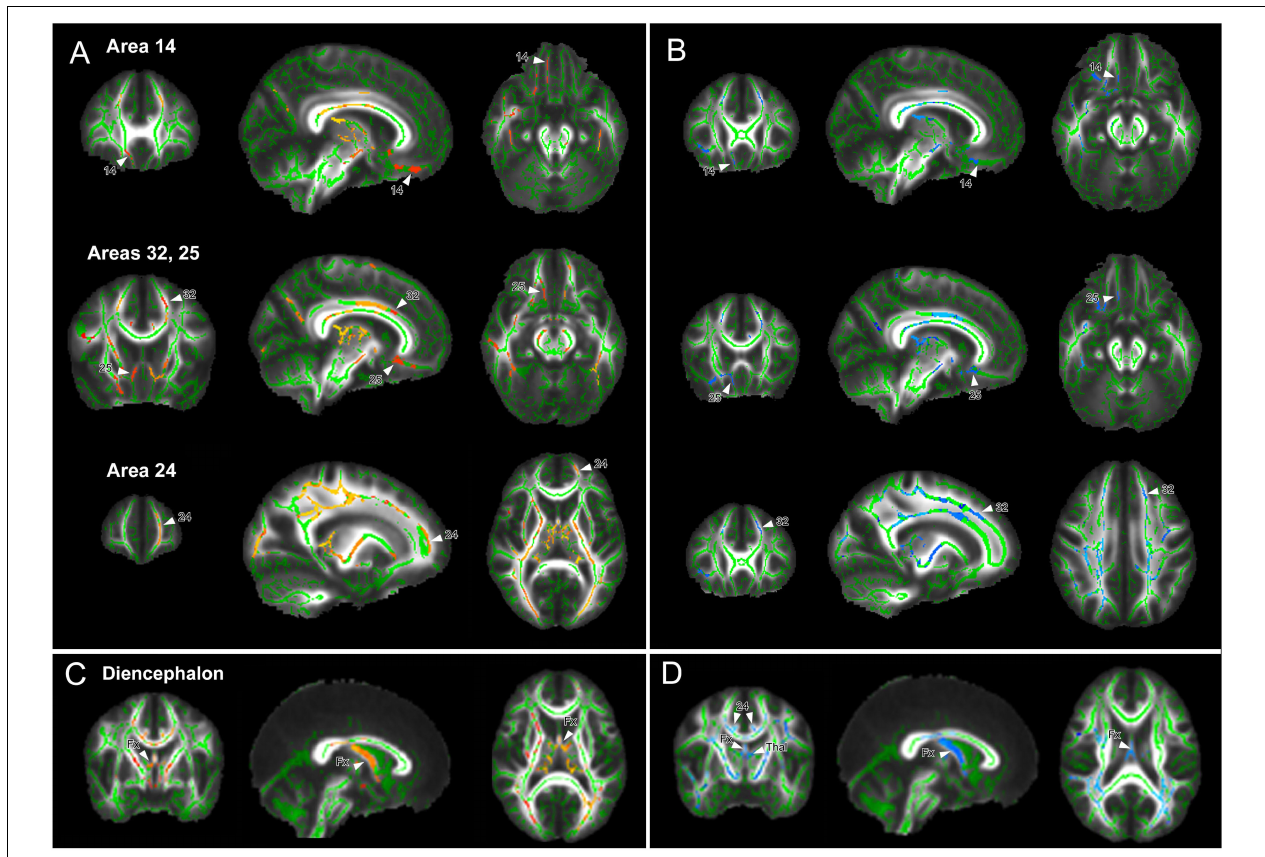
FIGURE 2 | White matter regions with significant changes in fractional anisotropy (FA) and radial diffusivity (RD) after correction for intracranial volume, age, and gender ( p ≤ 0.05). (A) Cortical regions with decreased FA (red-yellow) and (B) with increased RD (blue) in the very preterm/very low birth weight group. Decreased FA/increased RD was found in medial frontal areas, temporal, and extrastriate visual and parietal white matter. (C) Significant decreased FA (red-yellow) and (D) increased RD (blue) in diencephalon, including the fornix (Fx) and thalamic white matter (Thal) in children in the very preterm/very low birth weight